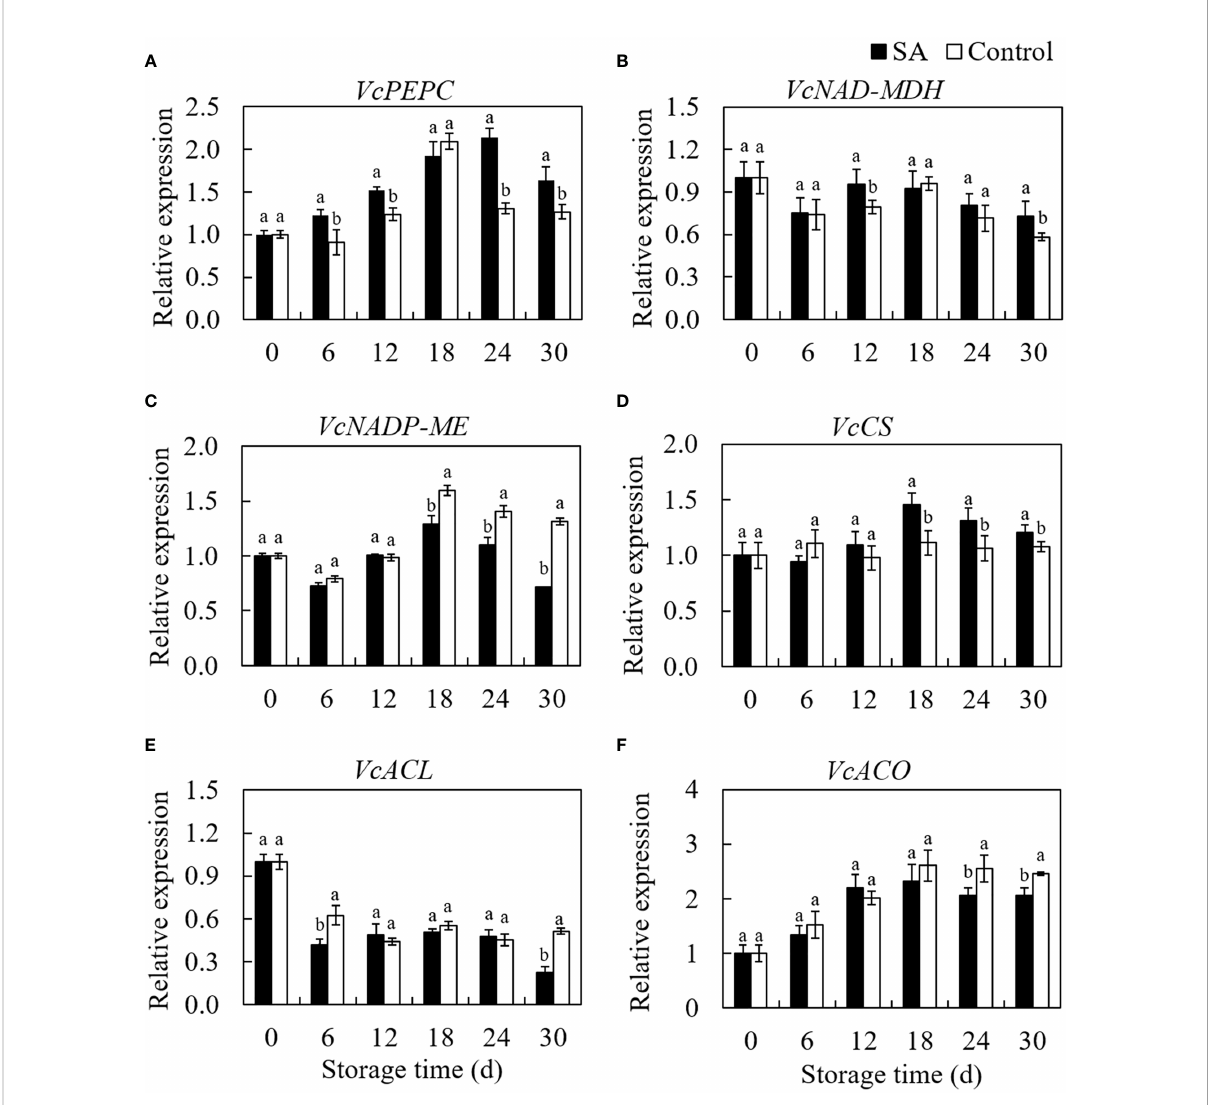
FIGURE 4 Effects of Salicylic acid treatment on genes expressions involved in organic acid metabolism of blueberry during cold storage. (A) , VcPEPC ; (B) , VcNAD-MDH ; (C) , VcNADP-ME ; (D) , VcCS ; (E) VcACL ; (F) , VcACO . Error bars represent the standard deviations of the means (n=3). The different lowercase letters indicate the signi fi cant differences between SA-treated and control fruit at each sampling time